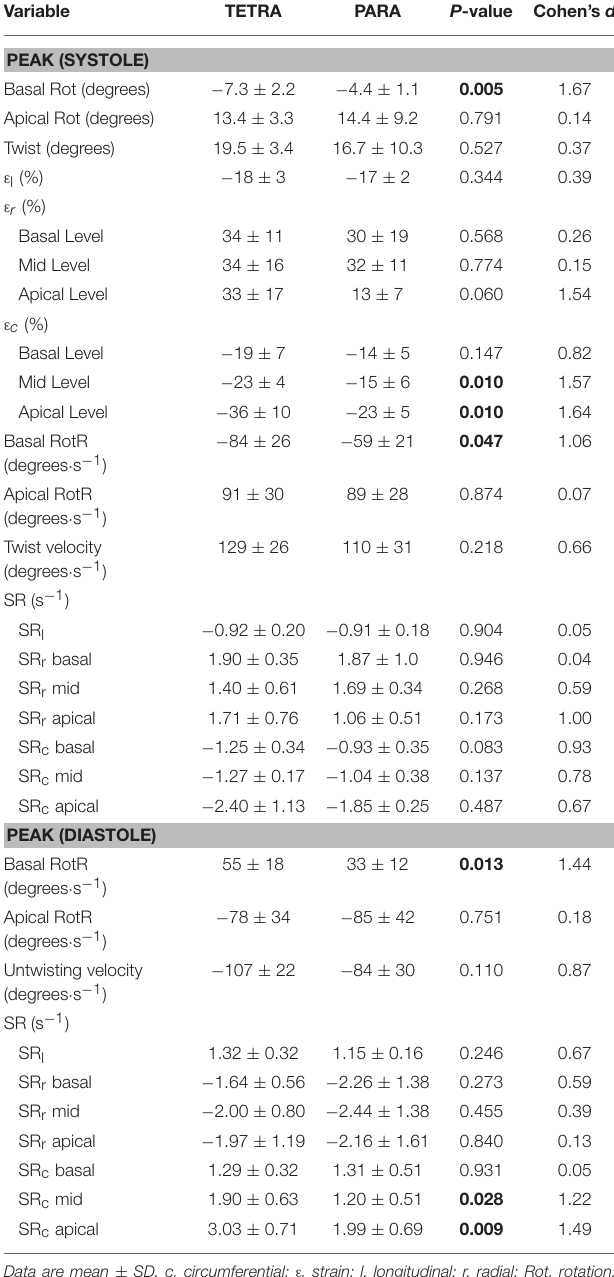
Data are mean ± SD. c, circumferential; ε , strain; l, longitudinal; r, radial; Rot, rotation; RotR, rotation rate; SR, strain rate. Bolded values in P-value column indicate significant between-group